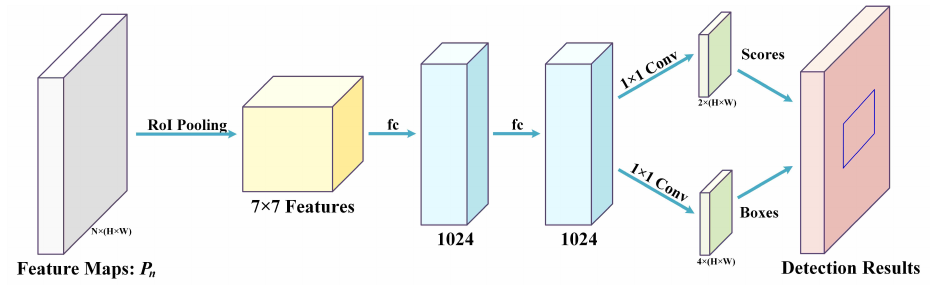
Figure 9. Architecture of the detection